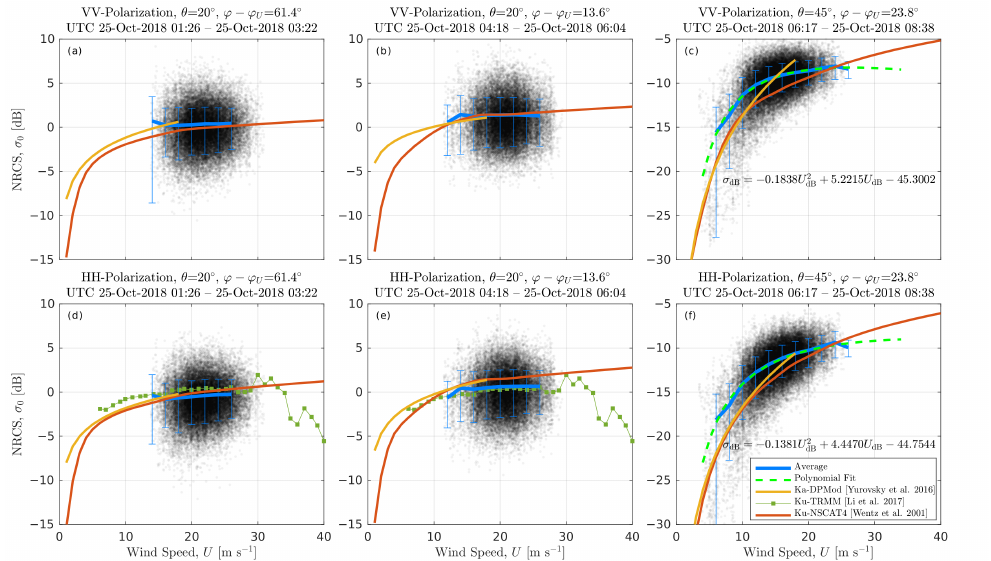
Figure 5. Measured NRCS at θ = 20 ◦ and θ = 45 ◦ for different radar-to-wind azimuths in comparison with KaDPMod, NSCAT-4, and TRMM GMFs. ( a – c )—VV-polarization, ( d – f